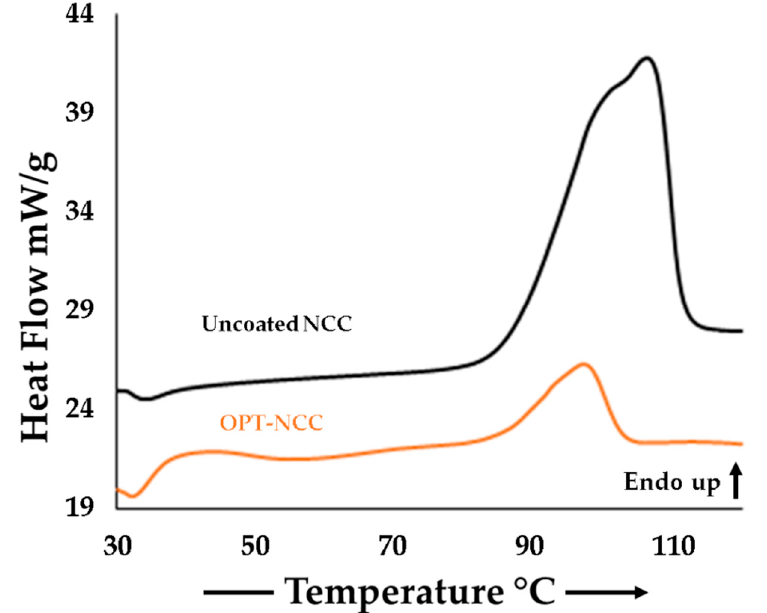
Figure 4. DSC thermograms depicting the melting endotherm for the uncoated (black) and OPT-NCC (orange).